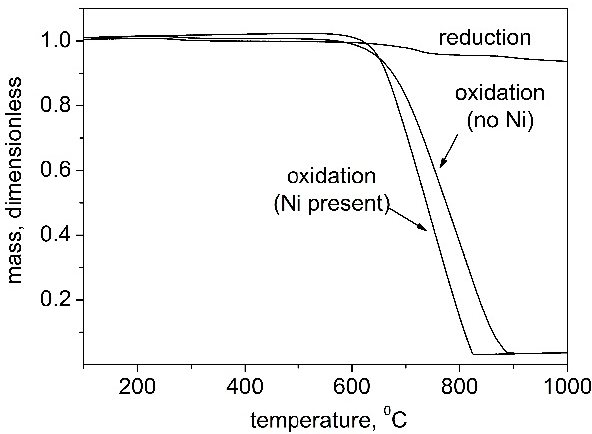
Figure 12. TGA for the “base” fabric in reducing oxidizing atmosphere.